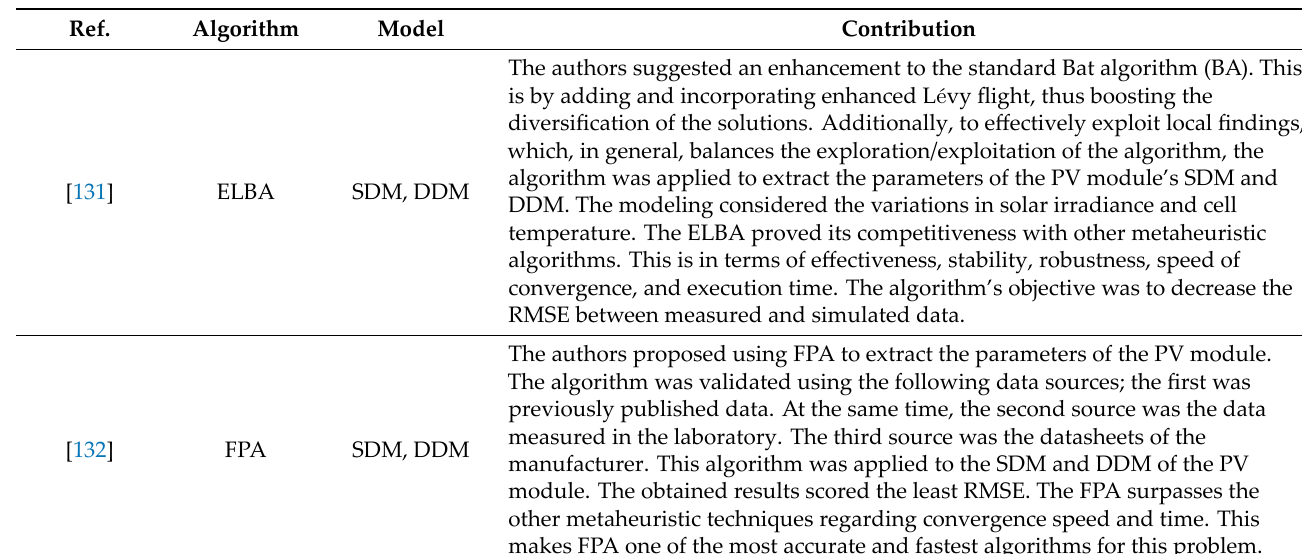
Table 7. Soft computing algorithms—nature‑based metaheuristic algorithms.